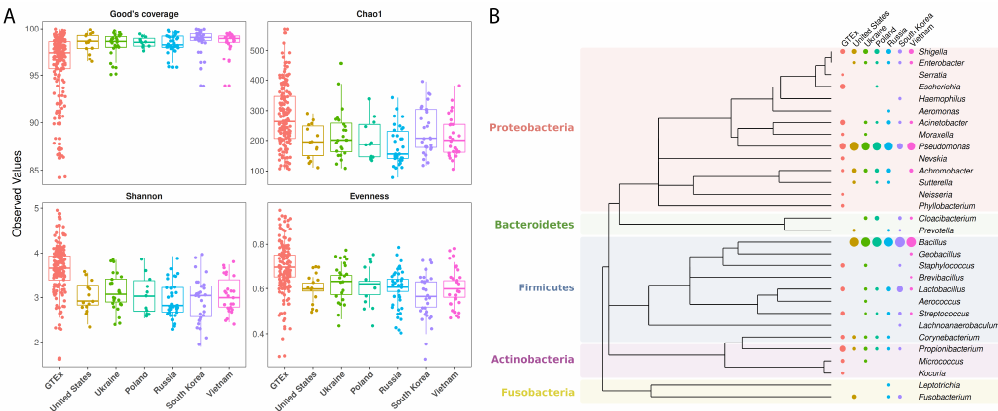
Figure 2. Alpha diversity and phylogenetic analysis of the gastric microbiome. ( A ) Good’s coverage, Chao1, Shannon and evenness in the inferred microbiome patterns. ( B ) Phylogenetic tree and respective abundance of genera found in the gastric microbiome (only genera that passed a mean threshold of 1% in at least one population are displayed in the graph). Samples are from non-cancer individuals from the GTEx dataset (United States n = 164, in brink pink) and cancer patients from the TCGA 2012 batch (United States n = 14 in gold; Ukraine n = 24 in limeade, Poland n = 11 in Caribbean green; Russia n = 34 in cerulean; South Korea n = 28 in purple and Vietnam n = 26 in pink). Within the cancer cohort, Bacillus was the dominant genus in European and East Asian samples, despite the relative abundance of this genus being significantly higher in the latter (30.4% and 38.1%, respectively; p = 4.1 × 10 −3 ). Bacillus was followed by Pseudomonas ( 24.2% and 15.9%; p = 7.9 × 10 −5 ) , Shigella (5.4% and 4.2%; p = 4.9 × 10 −3 ) , and Lactobacillus (2.3% and 6.4%; p = 0.1), while Helicobacter was vestigial (lower than 1%).